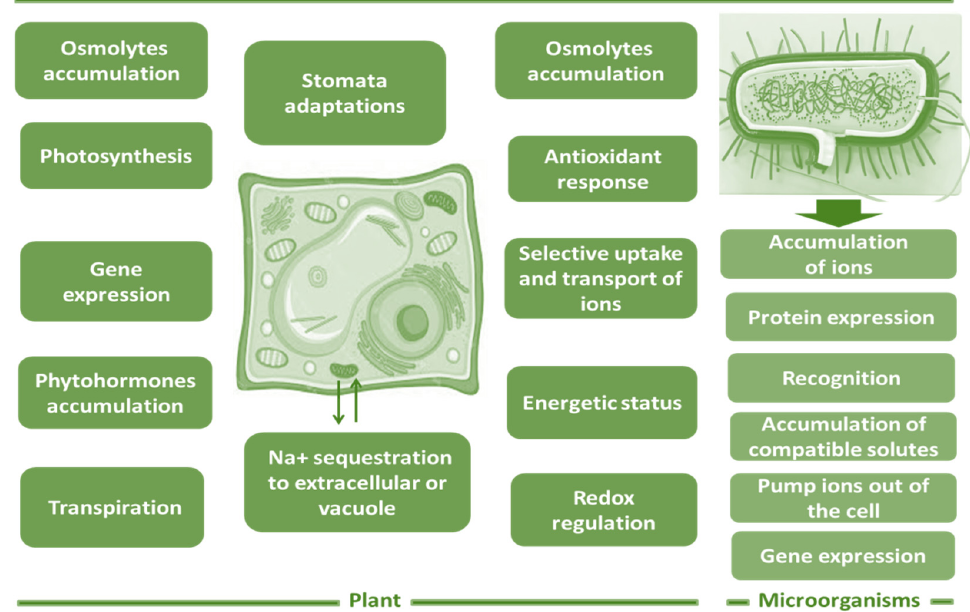
Figure 1. Strategies implicated in soil biodesalination by plants and